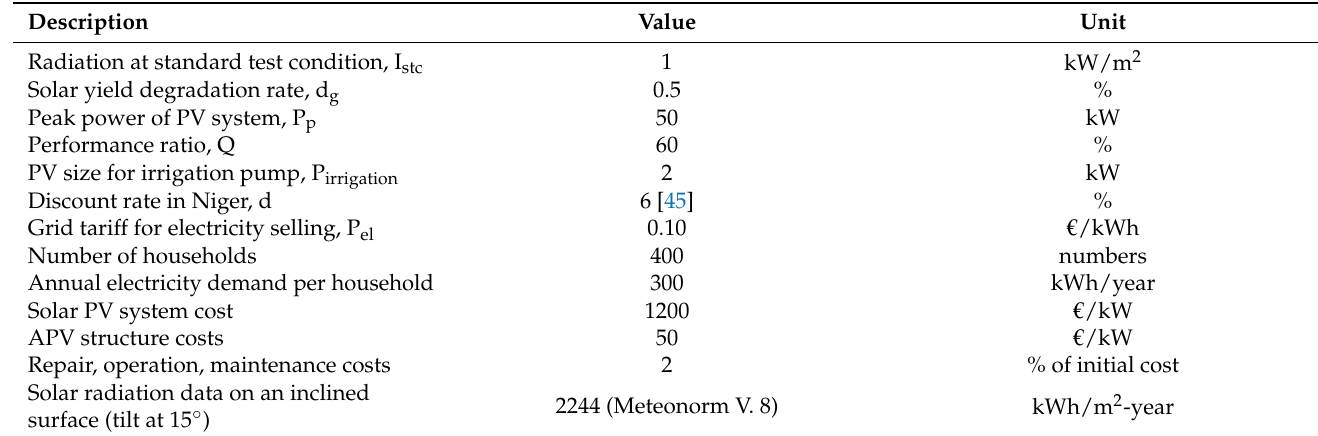
Table 5. PV specific